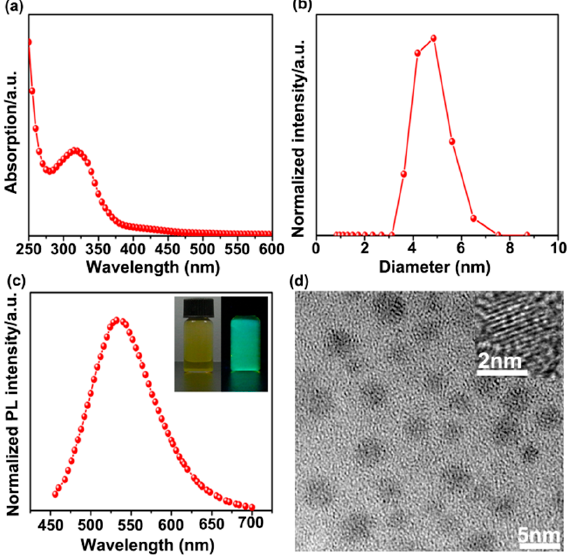
Figure 1. Physicochemical characterizations of SiNPs used in this study. ( a – c ) The representative UV absorption ( a ), dynamic light scattering (DLS) histogram ( b ), and photoluminescence (PL) spectra ( c ) of the SiNPs. The inset of ( c ) shows the appearance of SiNPs in water under ambient light (left) and 405 nm laser excitation (right). ( d ) TEM images of SiNPs.